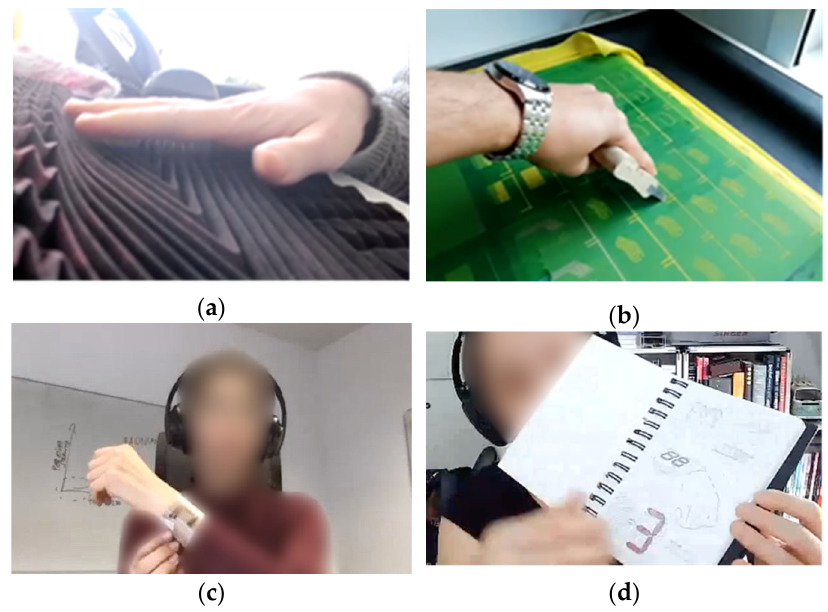
Figure 1. ( a ) Top left: P5 stroking a fabric they are working with. ( b ) Top right: P3 demonstrating manual fabrication methods on the lab tour. ( c ) Bottom left: P8 wrapping an interactive skin device around their wrist. ( d ) Bottom right: P4 showing her design sketches.